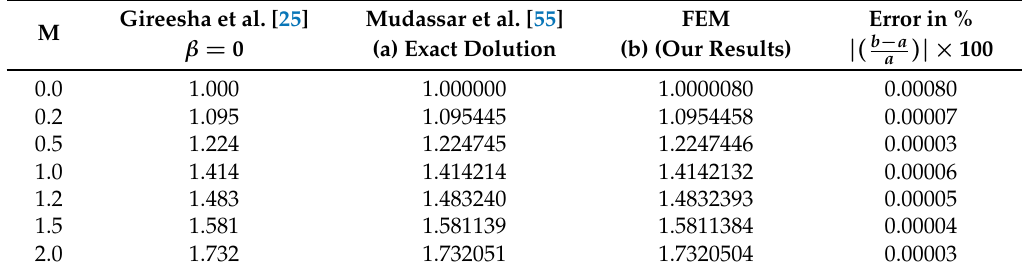
Table 3. Comparison of skin friction coefficient for various values of M.